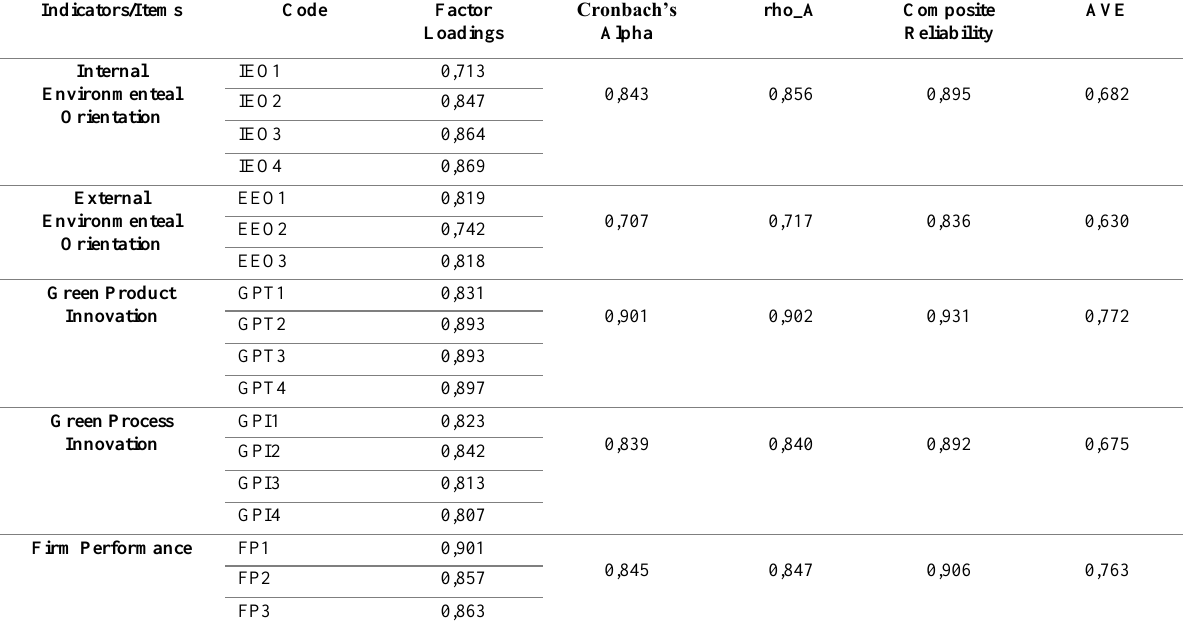
Table 1: Measurement model